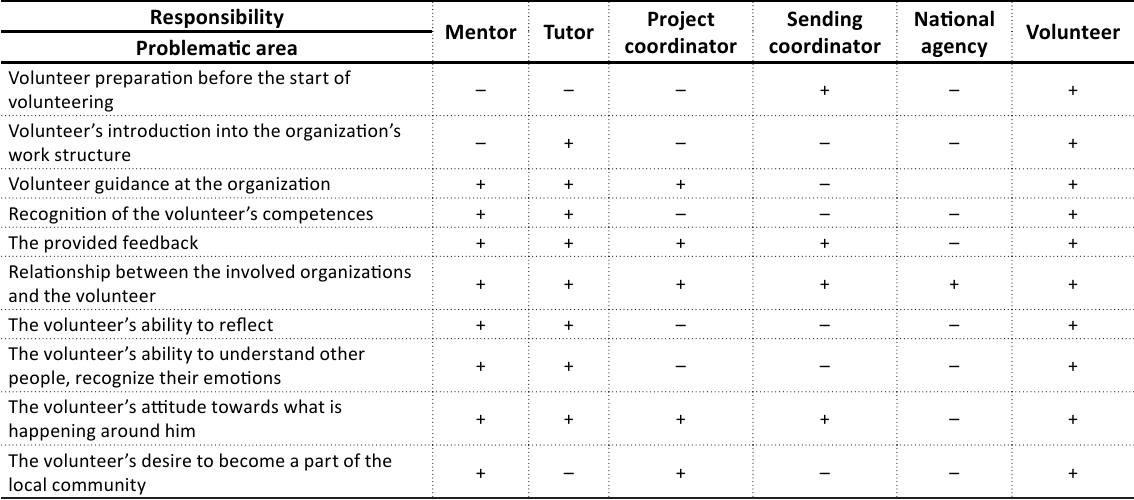
Source: Created by the